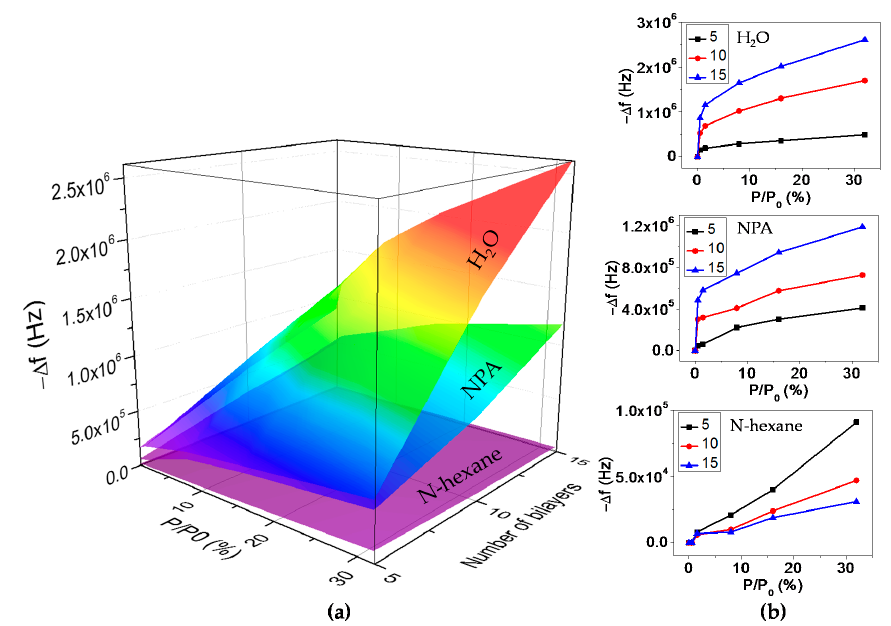
Figure 10. Frequency shift for the measurement of water, n-propyl alcohol (NPA) and n-hexane vapors. FBARs were coated with 5, 10 and 15 PSS/PDDA bilayers respectively. ( a ) Three-dimensional cube of FBAR responses to water, NPA and n-hexane vapors; ( b ) frequency shift for the measurements of water, NPA and n-hexane vapors respectively.